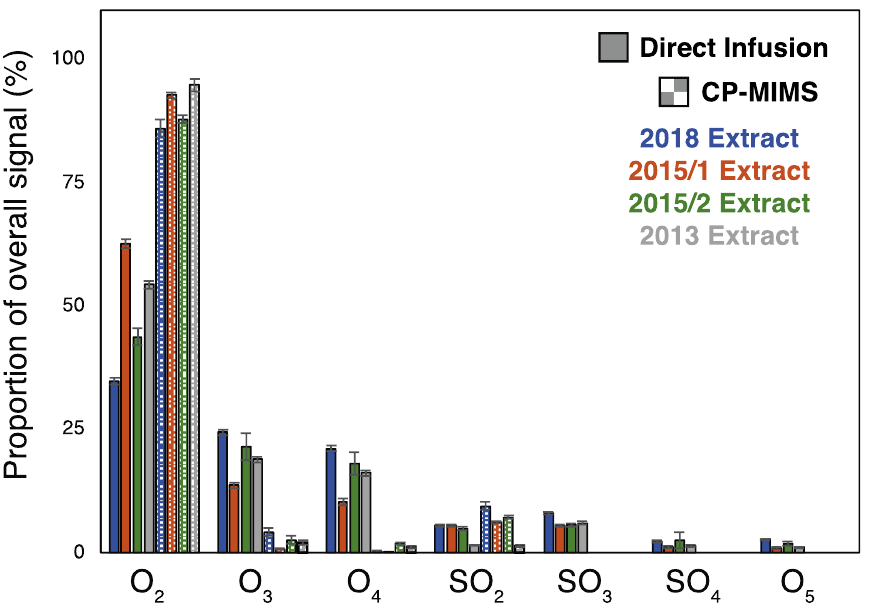
Figure 3. Class composition for direct infusion and membrane permeate across 4 OSPW extracts. Bars represent the mean signal contribution across a triplicate set of injections, and error bars represent the standard deviation across that triplicate set.